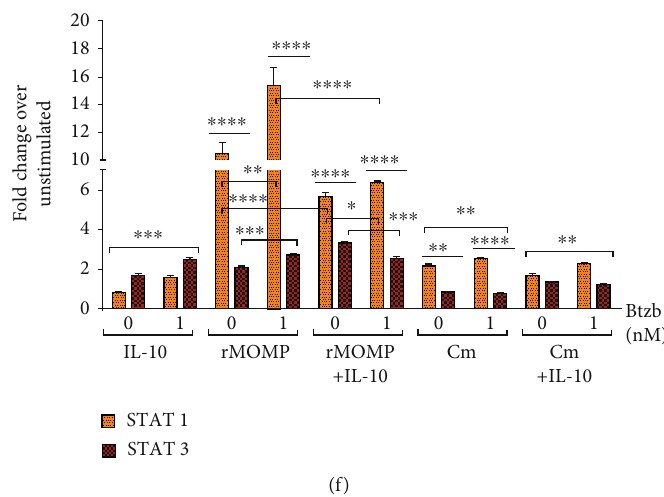
Figure 8: Inhibition of proteasomal degradation alters the IL-10 inhibition of in fl ammatory mediators and the transcriptional activation of SOCS and STATs in chlamydial macrophage cultures. Macrophages (10 6 /mL) were treated with 0, 1, and 20 nM of Bortezomib (Btzb) for 1h, followed by stimulation with rMOMP (1 μ g/mL) or Cm (MOI of 2) in the presence and absence of IL-10 for 24h. Post stimulation, cell-free culture supernatants were collected to quantify TNF (A), IL-10 (B), CCL5 (C) and CXCL10 (D) by speci fi c ELISAs. The mRNA gene transcripts for socs1 and socs3 (E) and stat1 and stat3 (F) were quanti fi ed via TaqMan qRT-PCR. An asterisk indicates a signi fi cant di ff erence ( P < 0.05), and P values were calculated as described in Figure 1 legend. Each bar represents the mean ± SD of samples run in triplicates. Each experiment was repeated at least 3